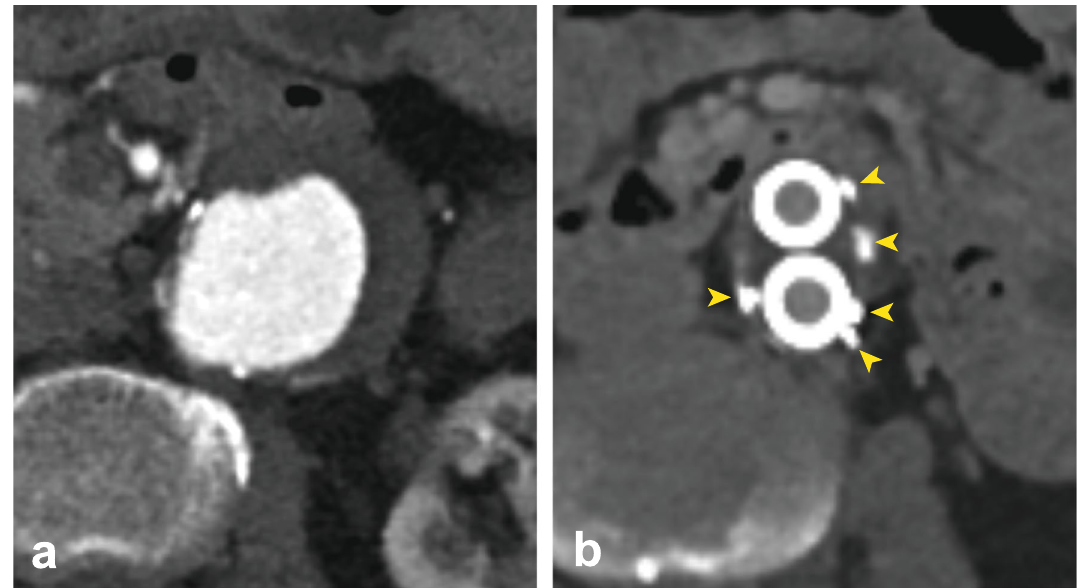
Fig. 5 a Preprocedure computed tomography angiography (CTA) of a 54‑mm diameter, 104‑mL infrarenal AAA sac. b Follow‑up CTA at 12 months, illustrating a reduction in aneurysm volume of 48 mL. The sac was treated with 31 shape memory polymer devices, totaling 38.75 mL of embolic material, which represented 117% of the calculated residual flow lumen volume outside of the endograft (Lombard Altura) based on preprocedural CTA analysis. Yellow arrows indicate the markers of the shape memory polymer